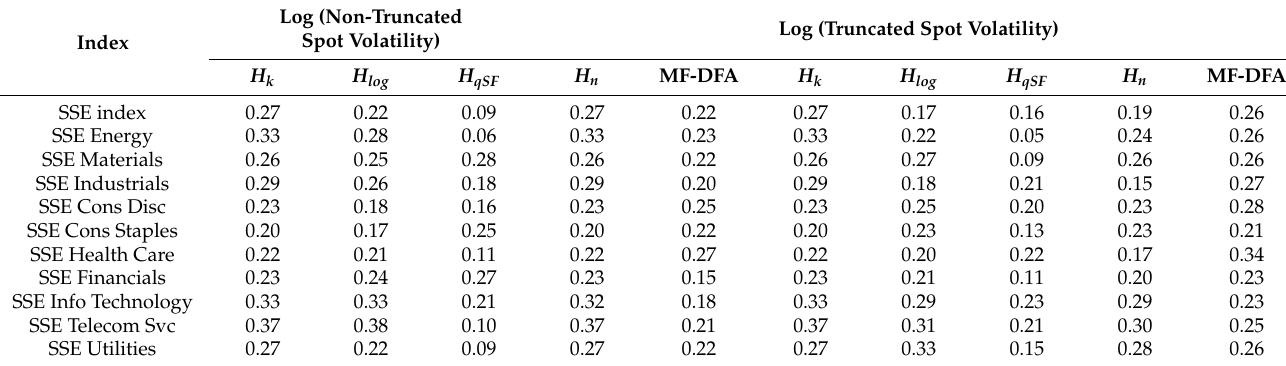
Table 5. Hurst parameter estimates for the logarithm of spot